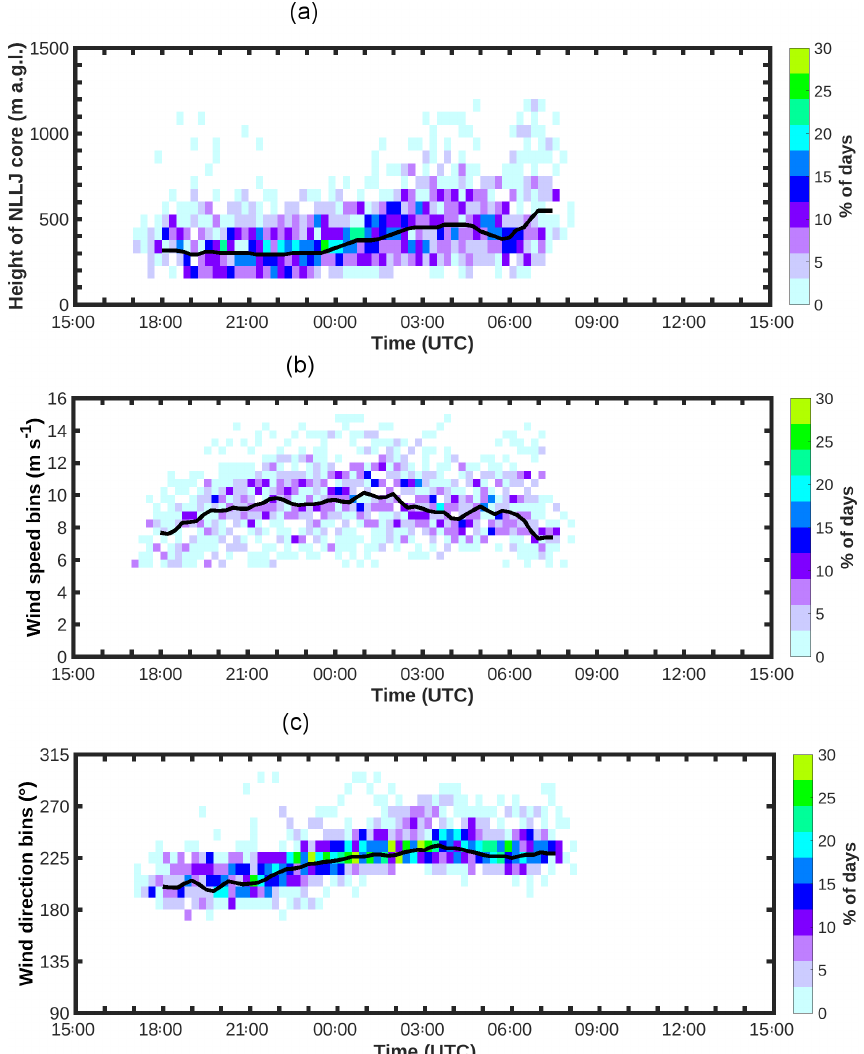
Figure 8. Distribution of the NLLJ (a) core height, (b) strength, and (c) direction at the Savè supersite. The color bar indicates the percentage of days (computed using the number of nights with NLLJ onset during the 20 June through 30 July period). The black lines in panels (a) , (b) , and (c) indicate the median jet core height, its strength, and its direction,